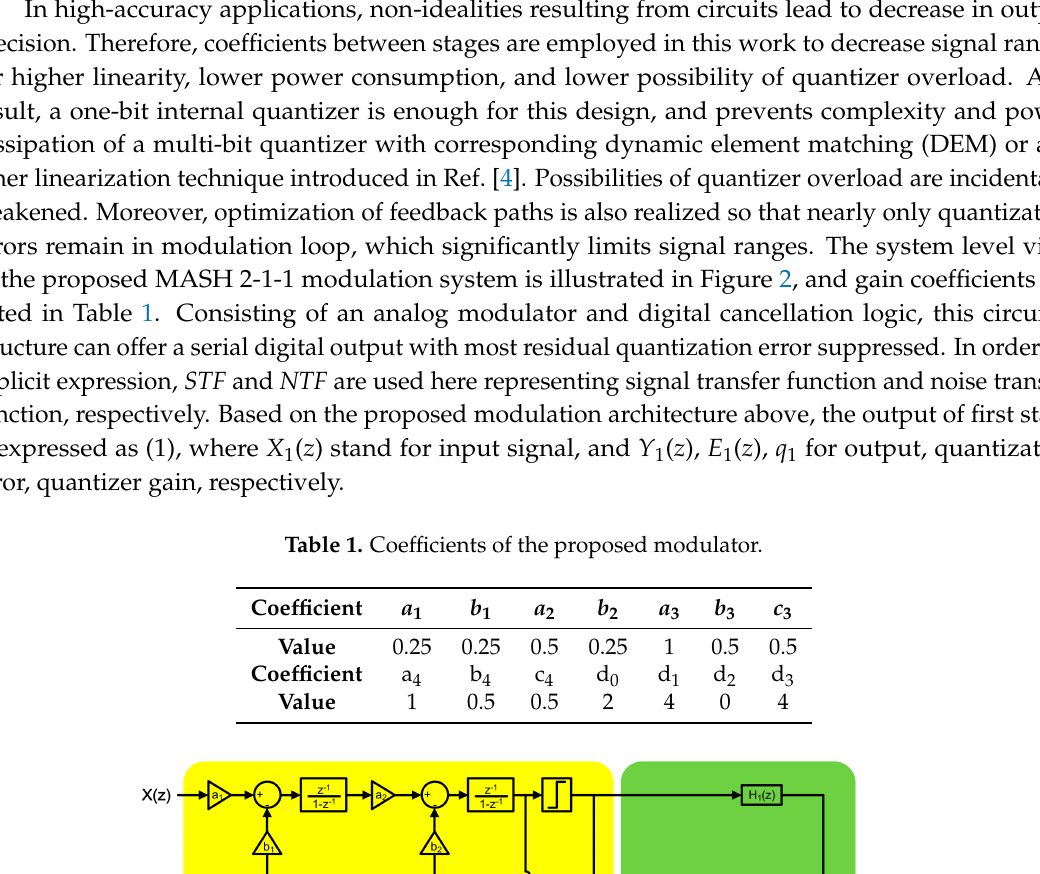
Table 1. Coefficients of the proposed modulator.